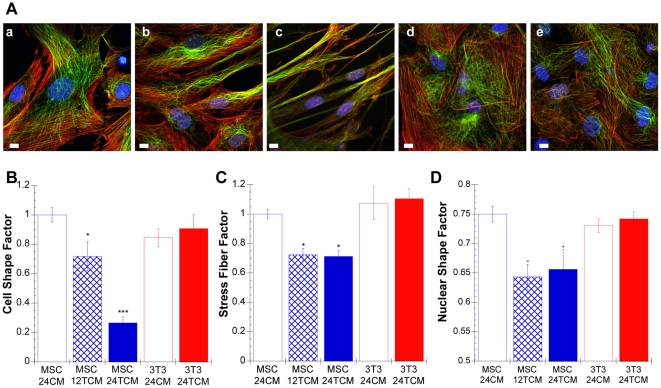
MSCs reorganize their cytoskeleton in response to tumor-secreted soluble factors.(A) Confocal micrographs of CM and TCM-treated MSCs (a–c) and 3T3 fibroblasts (d–e) stained with Phalloidin (F-actin, red), anti-α-tubulin (microtubules, green), and DAPI (nucleus, blue). The shape and cytoskeletal organization of CM-treated MSCs (a) and CM- (d) and TCM- (e) treated Swiss 3T3 fibroblasts were similar (24 hours after CM or TCM addition); whereas, TCM-treated MSCs were elongated with extended cytoskeletal filaments (b–c). MSC elongation increased between 12- (b) and 24- (c) hours, indicating that cytoskeletal changes may be progressive. Cytoskeletal parameters (B–D) were determined by analysis of confocal images with a custom MATLAB routine. The cell (B) and nuclear (D) shape factors were used to characterize the circularity of an elliptical outline of the cell or nucleus, respectively, with a shape factor of 1 indicating a perfect circle. The stress fiber factor (C) was used to characterize the density of actin stress fibers per cell area. Cytoskeletal changes observed in TCM-treated MSCs (b–c) were confirmed using the cytoskeletal parameters (B–D), which indicated dramatic reductions in cell and nuclear shape factors and stress fiber densities. (scale bars = 10 µm)